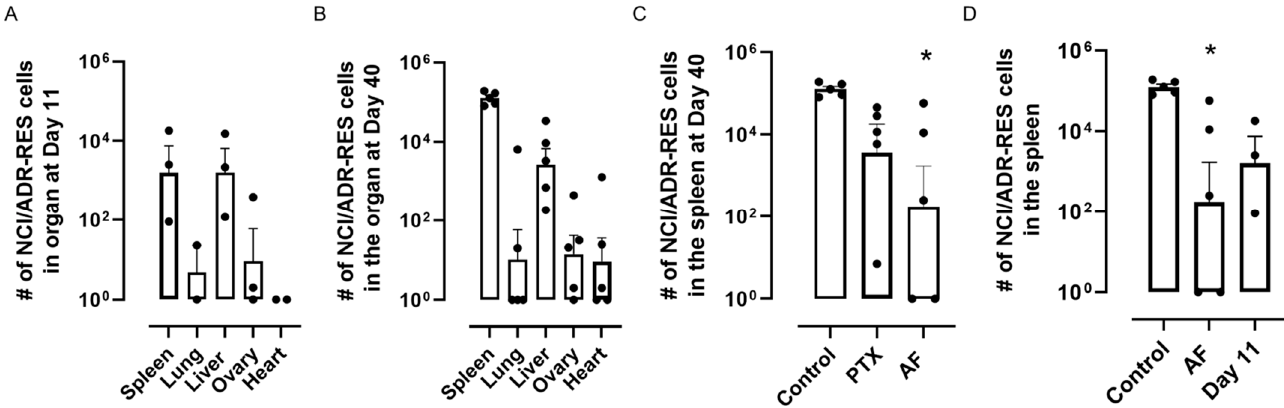
Figure 5. Taccalonolide AF reduces spleen micrometastases in a disseminated ovarian cancer xenograft model. ( A ) Quantification of NCI/ADR-RES cells in organs of animals 11 days after cell injections (n = 2–3 mice). ( B ) Quantification of NCI/ADR-RES cells in organs of animals 40 days after cell injections (n = 5 mice). ( C ) Quantification of NCI/ADR-RES cells in the spleens of animals treated with 20 mg/kg PTX, 1.5 mg/kg AF or vehicle on day 11 and harvested on day 40 (n = 5 mice). ( D ) Quantification of NCI/ADR-RES cells in the spleens of animals at the time of AF treatment (day 11) or with AF or vehicle at day 40. Closed circles represent individual data points. Statistical significance determined by one-way ANOVA with Dunnett’s (5C) or Tukey’s (5D) post hoc test for multiple comparisons and significant differences as compared to vehicle control are shown. * p < 0.05.